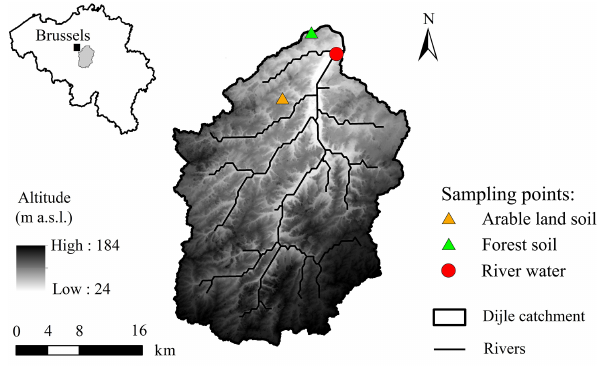
Figure 1. Location of the Dijle catchment and the river water and soil sampling